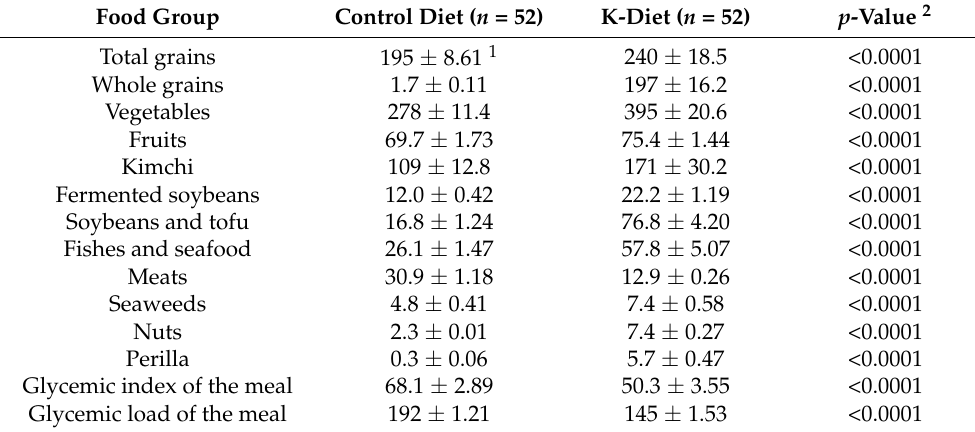
Table 2. Food consumption during the intervention (unit: